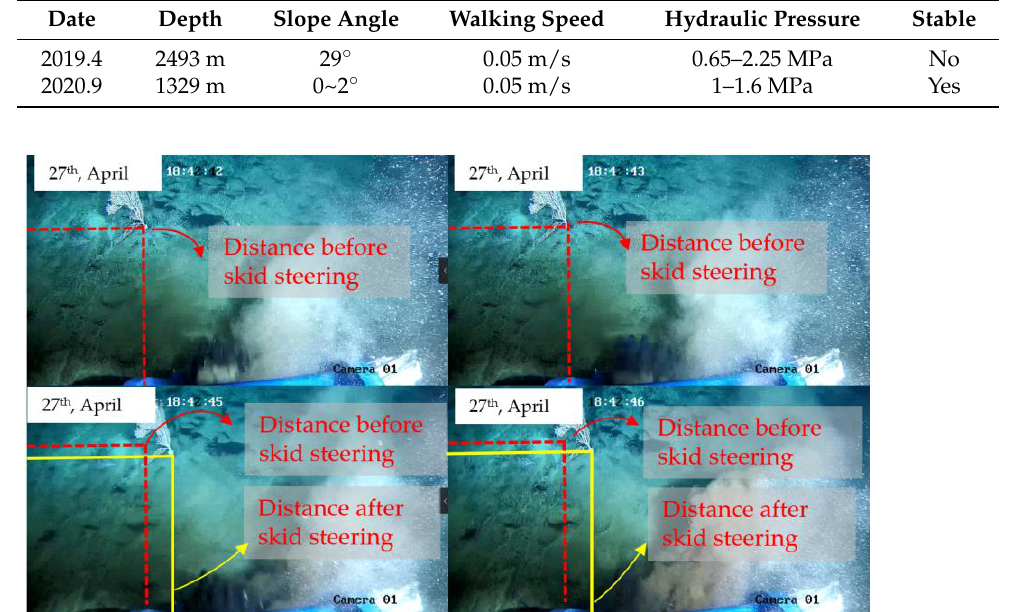
Figure 20. Skid steering of the vehicle.